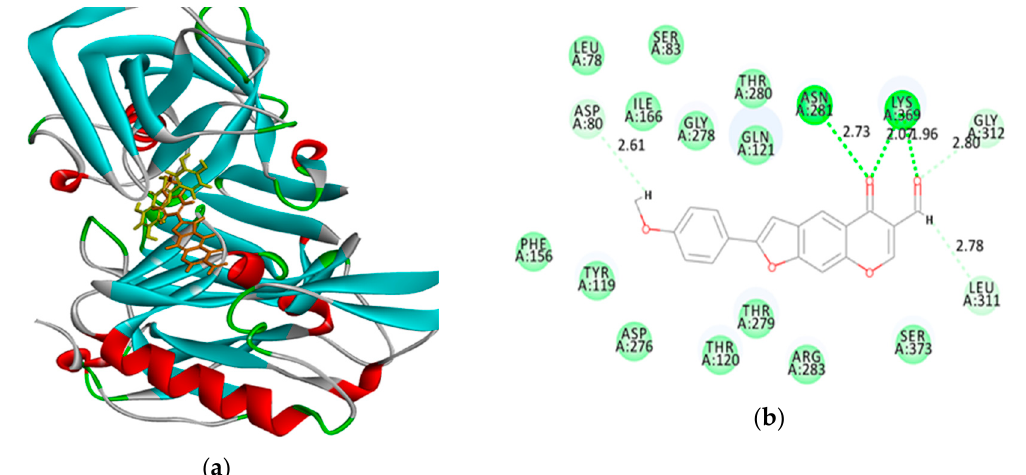
Figure 5. Quercetin (yellow) and 2f (orange) represented with β -secretase (3IXJ) in ribbon format (a),